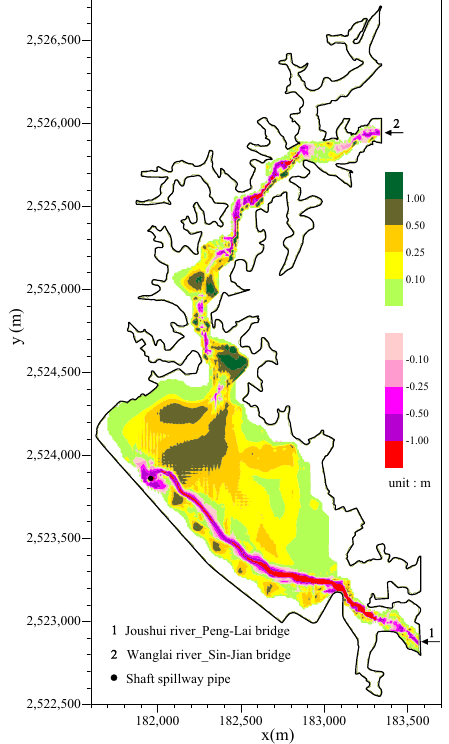
Figure 9. Bed evolution in the reservoir during a 10-year return period, t = 120 h.